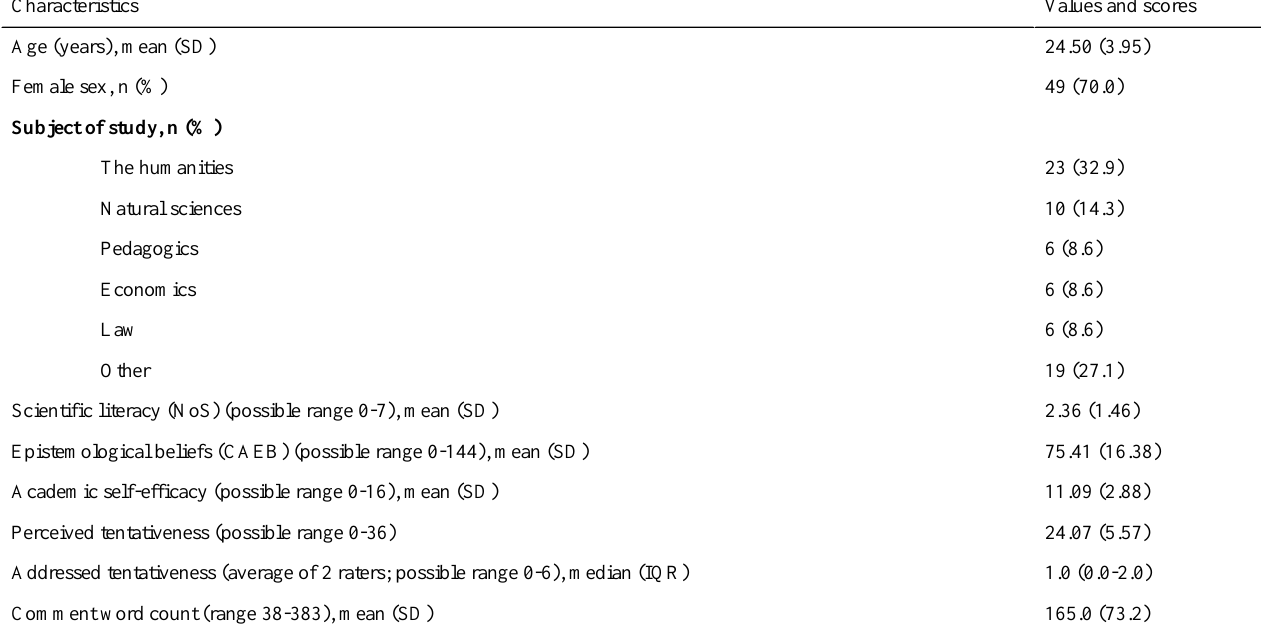
Values and scoresCharacteristics